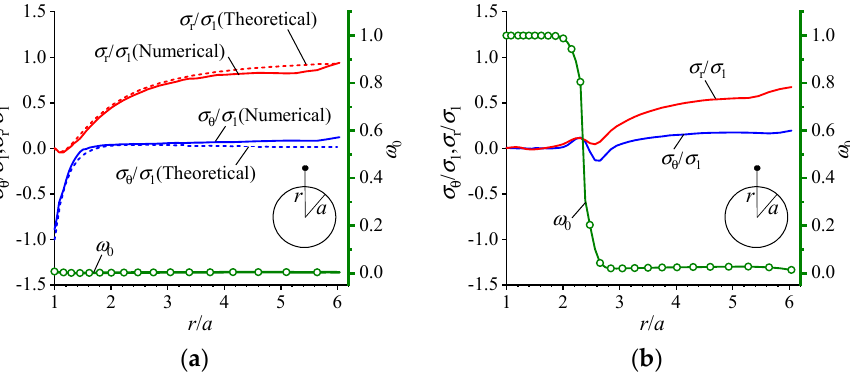
Figure 21. σ r / σ 1 , σ θ / σ 1, and ω 0 vs. r / a vs. distance ratio r / a along vertical plane in specimen HA. ( a ) σ 1 = 1 MPa; ( b ) σ 1 = σ p .